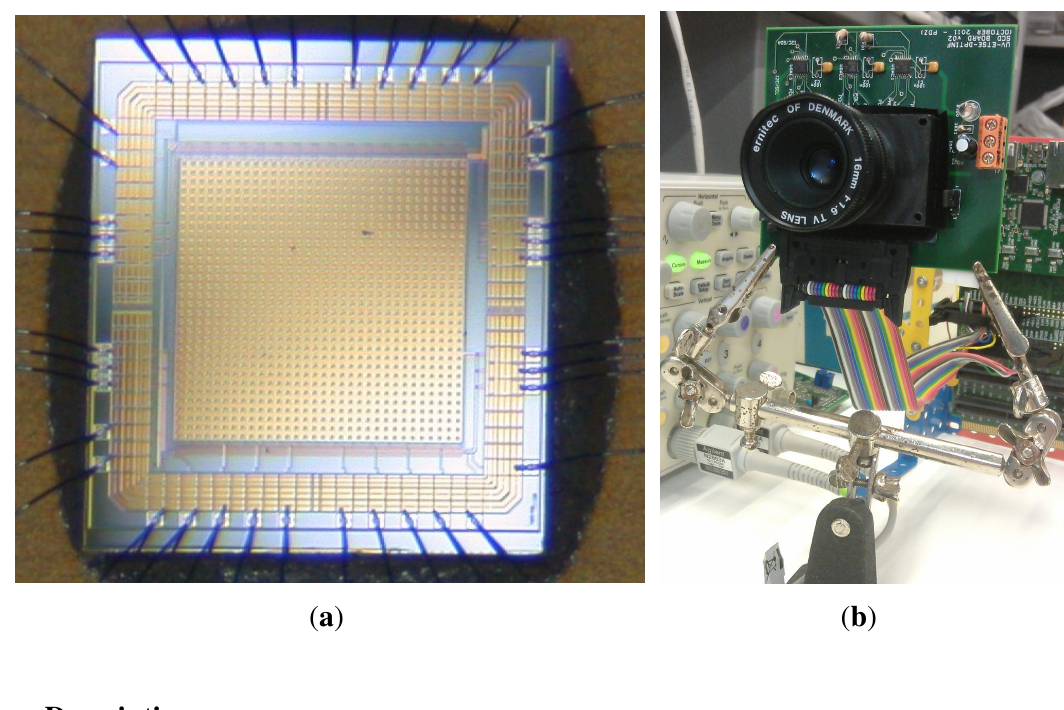
Figure 1. Selective Change Driven (SCD) sensor and camera board. ( a ) SCD sensor; ( b ) SCD camera